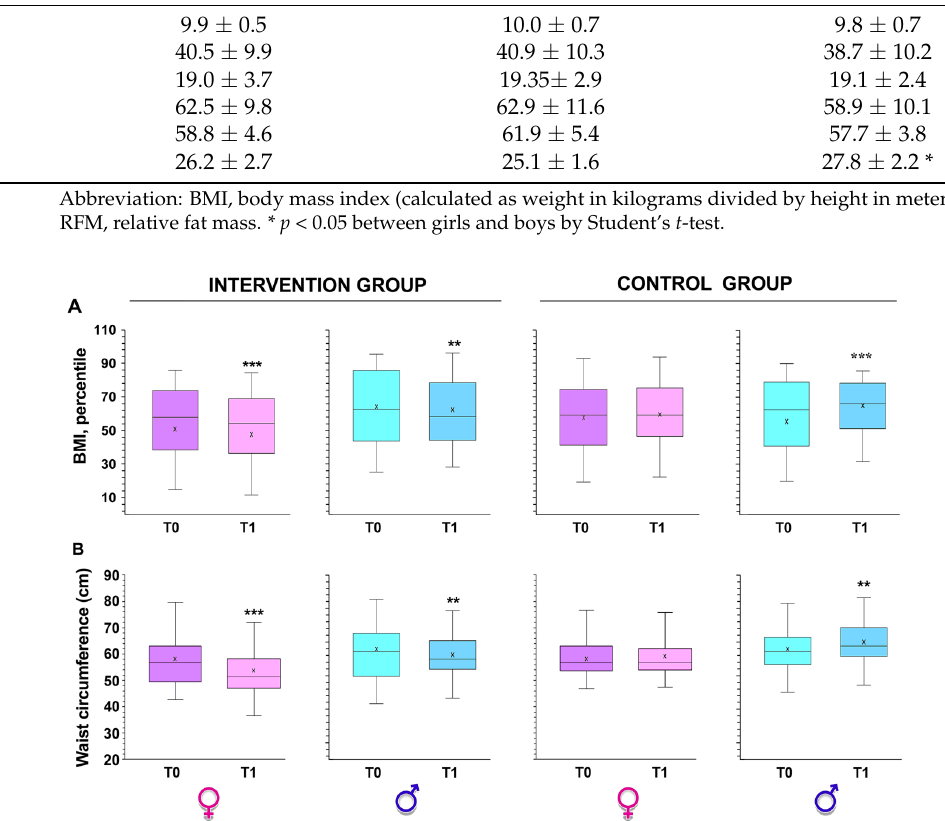
Table 3. WHR and RFM measurements at T0 and T1. T0